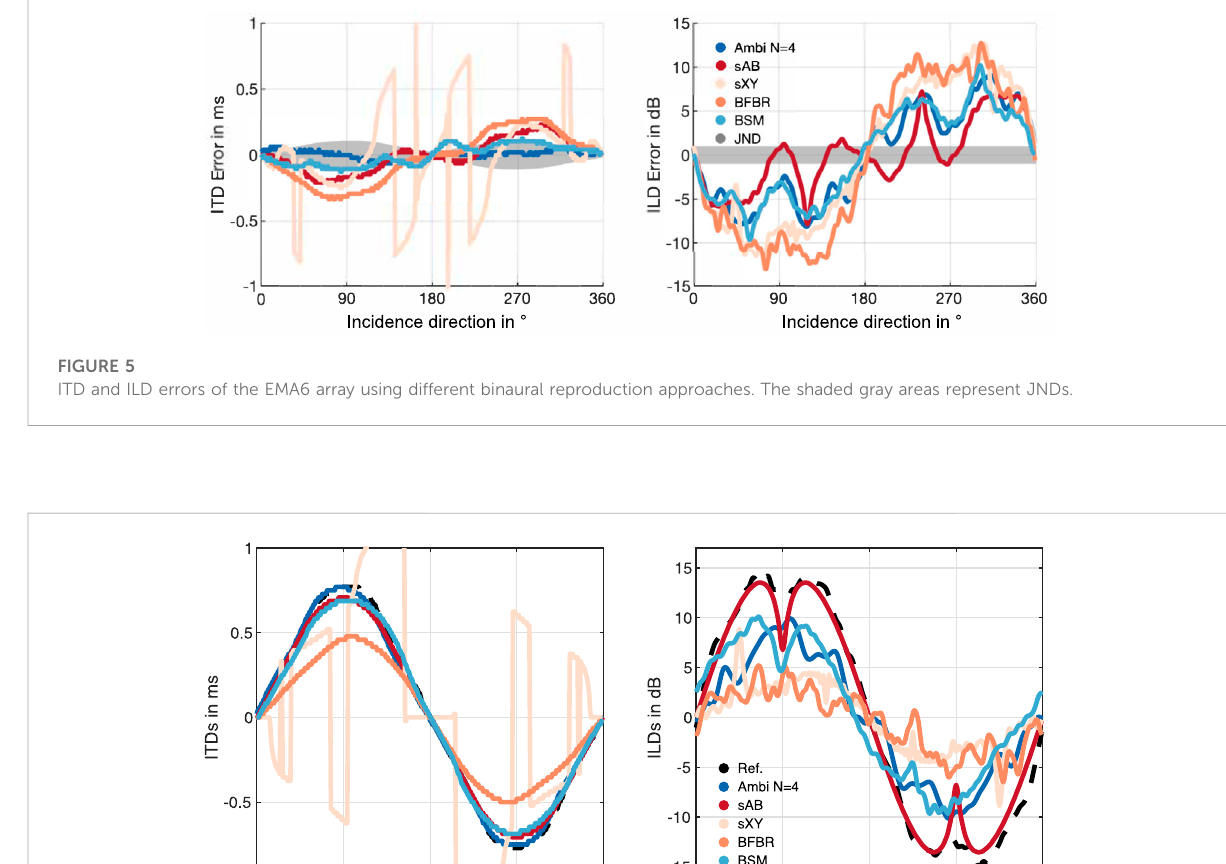
Frontiers in Signal